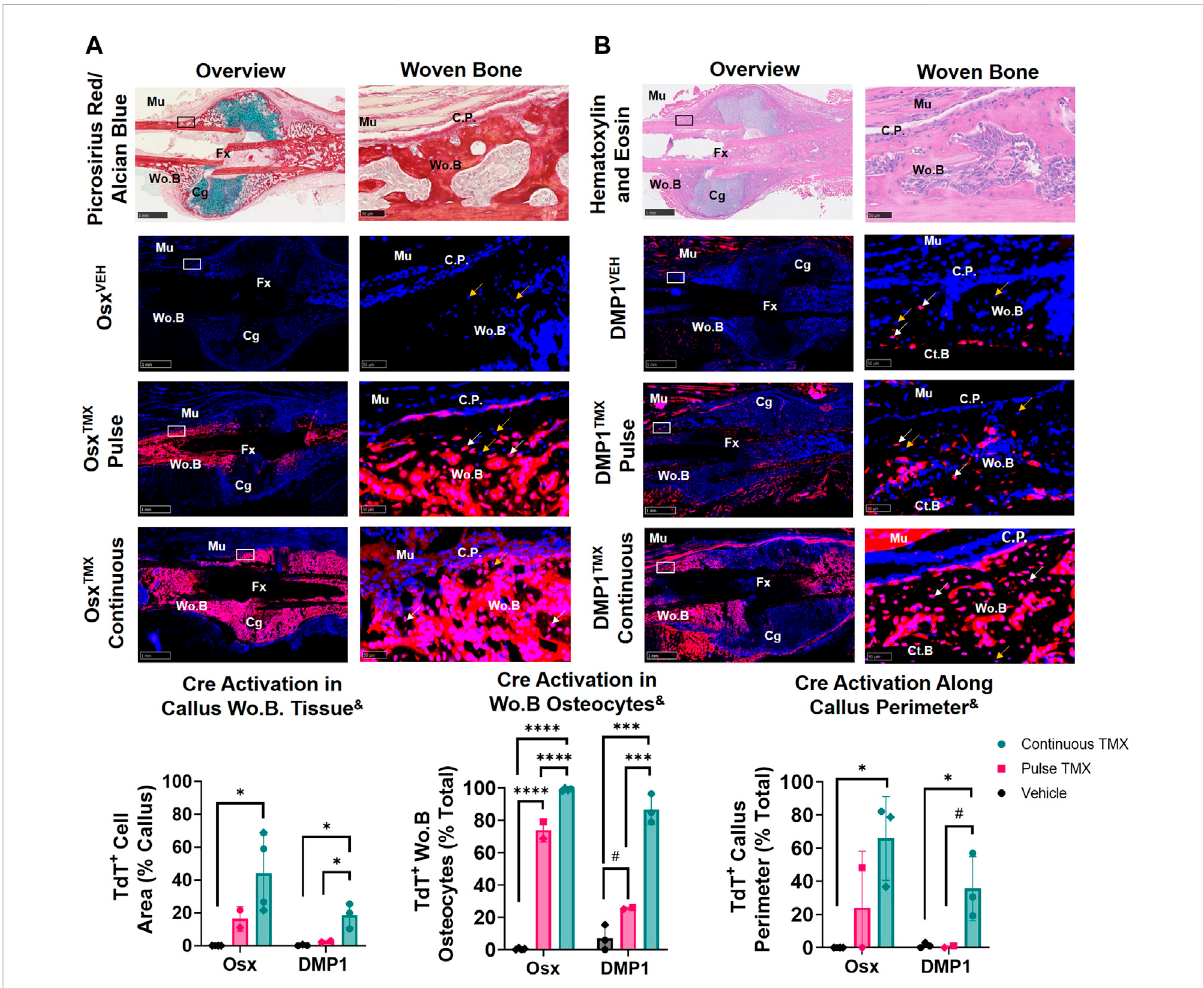
FIGURE 4 Pre-existing Osx + (panel (A) ) and DMP1 + (panel (B) ) lineage cells contribute to varying extents of woven bone osteocytes during transverse fracturehealing(intramembranousregion).2.5X(Overview;scalebar1 mm)and40Ximages(wovenbone-scalebar50 μ m;black/whiteROIboxes) were randomly taken and averaged from two regions of interest at the callus periphery > 2 mm from PID14 fracture site (Fx) known to contain predominantly wovenbone (Wo.B). TdTomato positive (TdT + ) callus area were calculated from automated thresholding for TdT + area between cortical bone (Ct.B) and skeletal muscle (Mu). Wo.B TdTomato positive (TdT + ) osteocytes (white arrow) were normalized to total number of osteocytes (TdT + and TdT − cells-orange arrow). TdT + periosteal callus perimeter was normalized to total callus perimeter length (C.P.). Data presented as mean ± SD with n = 2-4 per group. Mousesex of each data point is represented by shape (circle – female; diamond – male). & Signi fi cant Tamoxifen Effect by 1-WAY ANOVA. # p < 0.10; * p < 0.05; *** p < 0.0005; **** p < 0.00005 Signi fi cantly Different by Tukey